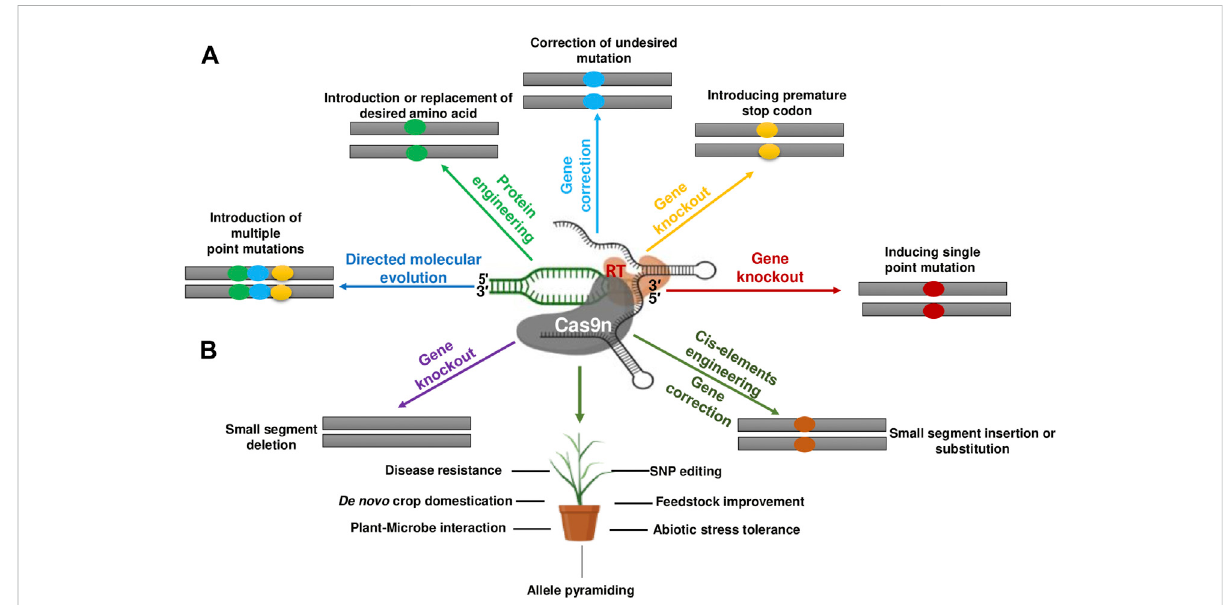
FIGURE 6 Prime editing-mediated genetic modi fi cations and their potential use in cereals. (A) Various kinds genetic/sequence manipulations/ modi fi cations that are potentially possible through prime editing in plants. (B) Different applications of prime editing in various cereal crops. The rectangles specify mutation and different colors within them indicate different types of mutations. The yellow colored ovals denote the DNA segment inserted or replaced using prime editing. Cas9n, Cas9 nickase; SNP, single-nucleotide polymorphism; RT, reverse